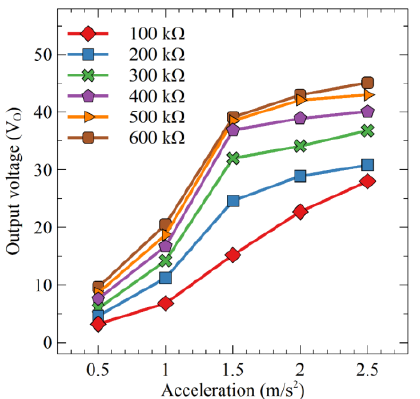
Figure 14. Output voltage of FBRJT in Test 2.